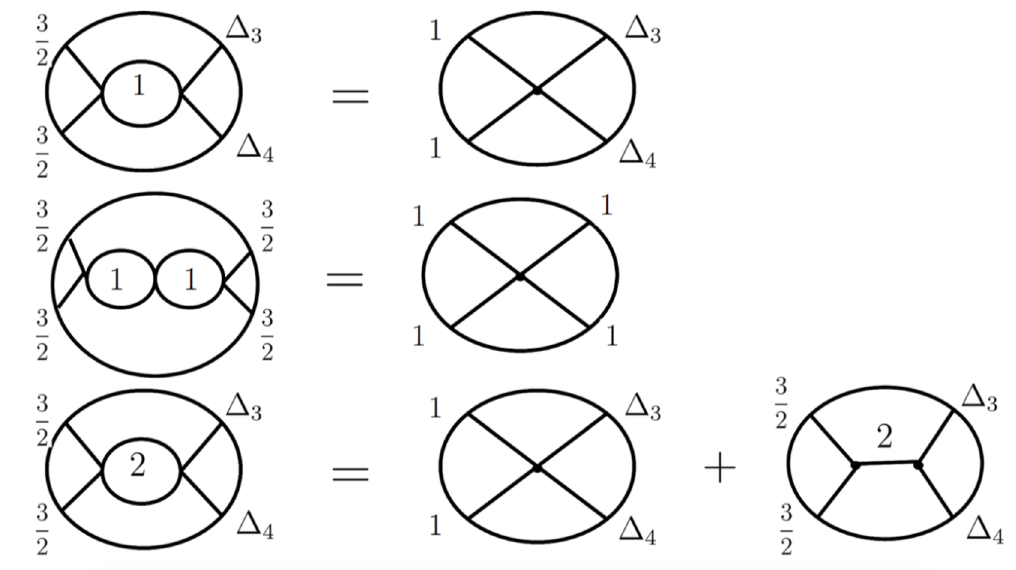
JHEP06(2020)049 Figure 9 . Three examples of 1 and 2-loop diagrams written in terms of contact and exchange diagrams. This arises from Identity 6. The bottom (cid:12)gure also uses Identity 4. We are suppressing numerical coe(cid:14)cients in these plots. Figure 10 . Examples of alternating integer and half-integer bubble Witten diagrams which are equal to contact and exchange diagrams. Using Identities 5,6, and 7. The bottom diagram uses eq. (3.29). We are suppressing numerical coe(cid:14)cients in these plots. { 15